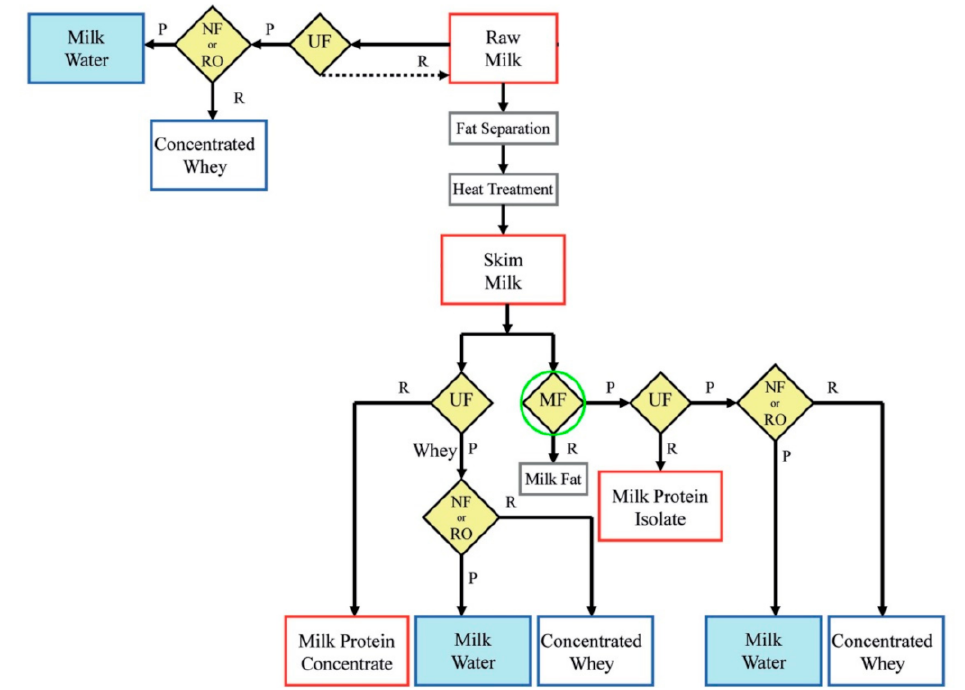
Figure 3. Process scheme for milk treatment and production of by-products with specific nutritional purposes (e.g., whey and milk protein), where MF is used for fat separation (adapted from